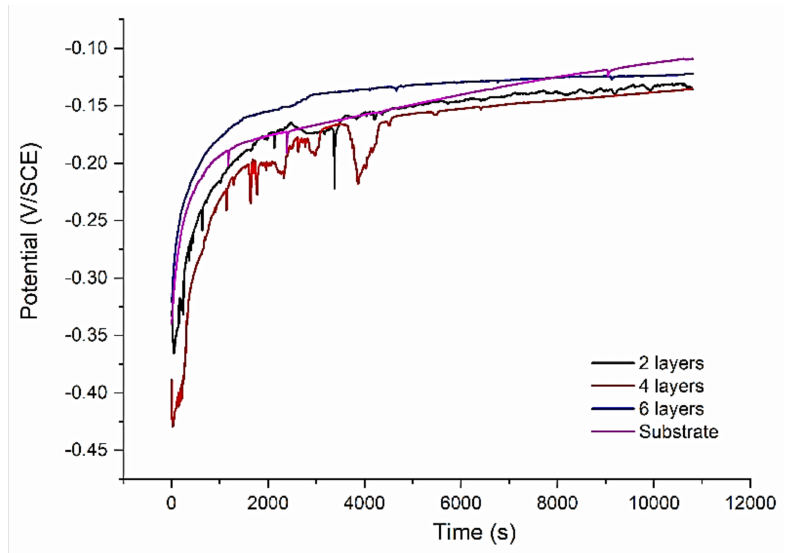
Figure 7. Open-circuit potential vs. time after 3 h in 3.5% NaCl water solution at 25 ◦